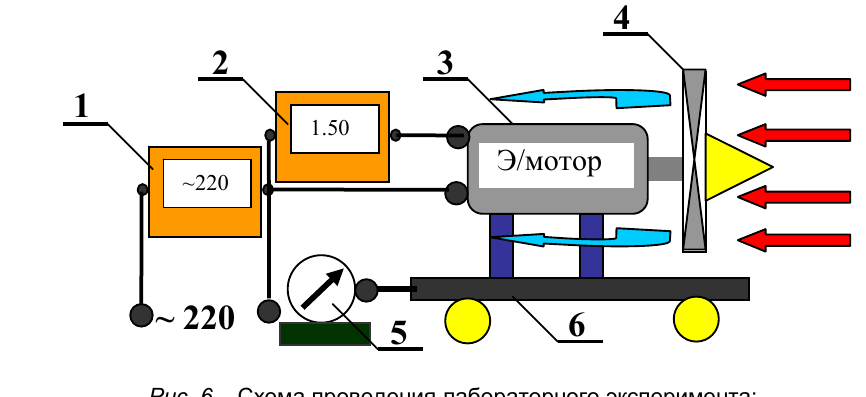
Figure 6 – Schematic presentation of the laboratory experiment: 1 – voltmeter; 2 – ampere meter; 3 – electric motor; 4 – tested propeller; 5 – dynamo meter; 6 – rolling